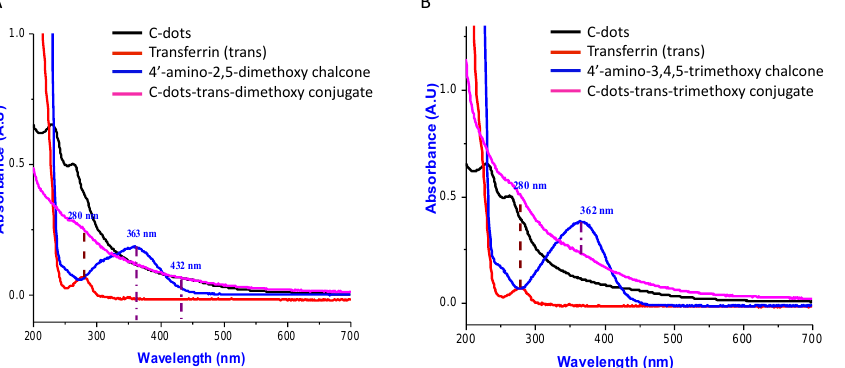
Figure 5. Schematic illustration of the synthesis of the C-dot-trans chalcone conjugates. Carboxyl groups are activated by EDC/NHS then reacted to the amino groups of transferrin and 4′ amino dimethoxy ( A ) or 4′ amino trimethoxy ( B ) chalcone. For simplicity only one molecule of transferrin and chalcone are shown. Not drawn to scale.